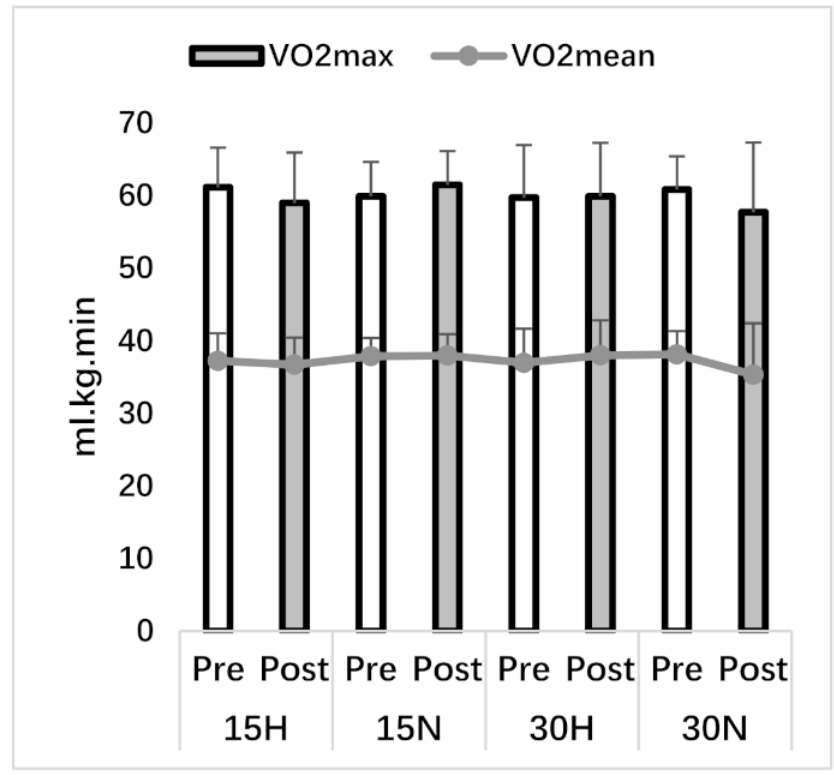
Figure 2. VO 2max and mean values.